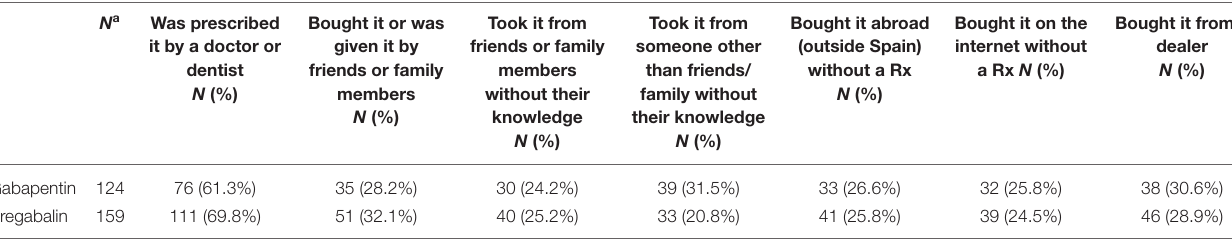
TABLE 7 | Reported method of drug acquisition in Spain.